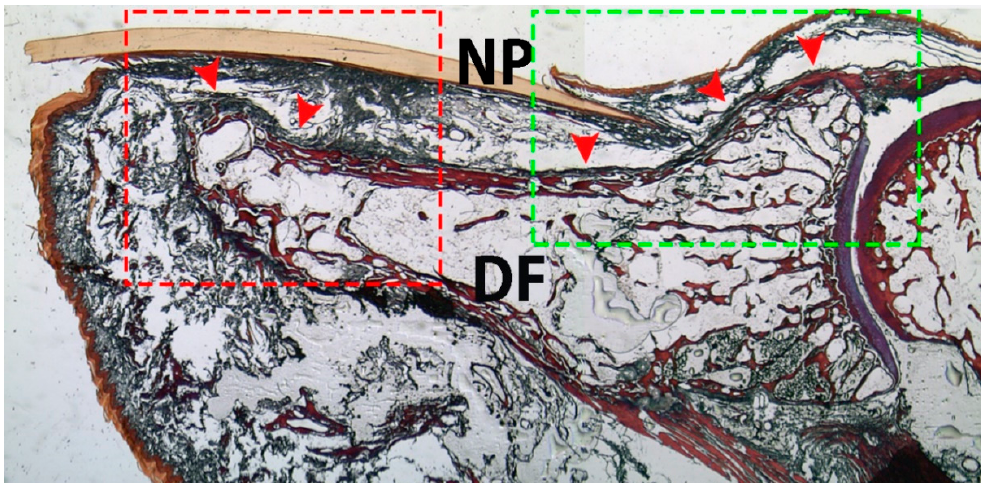
Figure 4. Sagital section of the thumb. The superficial fibers of the EPL tendon bundles extend to the dorsal aspect of the distal phalanx of the thumb (arrowheads). Convex and concave structures form the interphalangeal joint of thumb. The red and green squared areas correspond to Figures 5 and 6, respectively. NP—nail plate; DF—distal phalanx. (5× magnification). Tetrachrome VOF-III GS stain (light green SF/or fast green FCF, methyl blue, Orange G, and acid fuchsin).